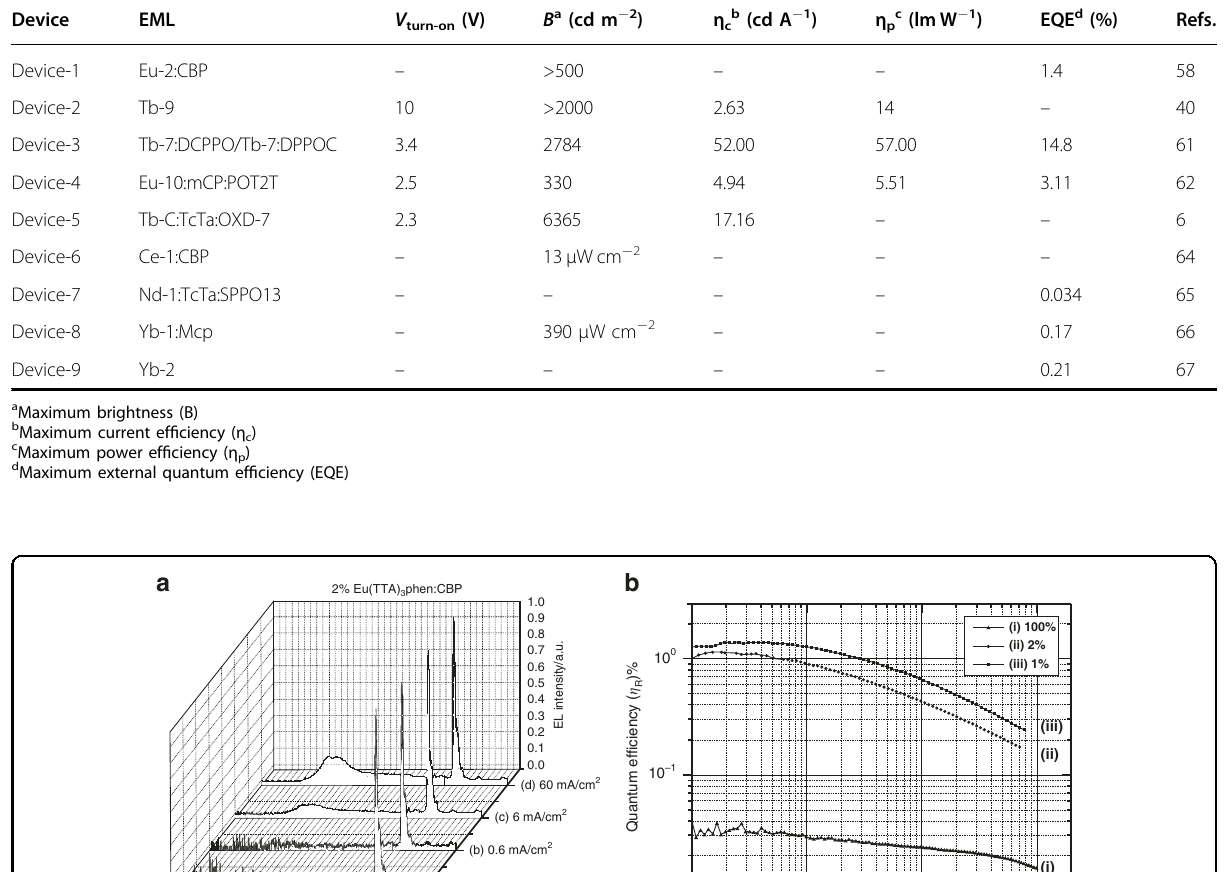
holes injection. Finally, they fabricated EL device with the structure of ITO/MoO /4,4 ′ ,4prime ″ -tri(9-carbazoyl)tri- 3 phenylamine (TcTa)/Tb-7 (Fig. 5):di(9H-carbazol-9-yl) (phenyl)phosphine oxide (DCPPO)/Tb-7:DPPOC/tris-(3- (3-pyridyl)mesity)borane (3TPYMB)/LiF/Al (Device-3, Table 3), and the device achieved the maximum η of c 57 cd A − 1 , and EQE of 14.8%. These performances were amongst the best-reported values of terbium complex- based devices. In 2017, Zhao et al. constructed a device composed of ITO/MoO /1,3-bis(9-carbazoly)benzene 3 (mCP)/mCP:(1,3,5-triazine-2,4,6-triyl)tris(benzene-1,3- diyl)tris(dipenylphosphine oxide) (POT2T):Eu-10 (Fig. 7)/ POT2T/4,7-diphenyl-1,10-phenanthroline (Bphen)/LiF/ Al (Device-4, Table 3), which displayed low turn-on vol- tage of 2.5 V 62 . In 2019, Girotto and co-workers reported co-host structure composed of TcTa and 2,2 ’ -(1,3-phe- nylene)bis[5-(4-tert-butylphenyl)-1,3,4-